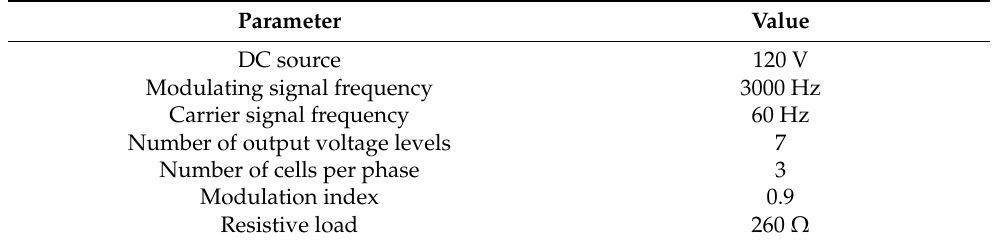
Table 1 shows the design specifications. Table 1. Topology design specifications